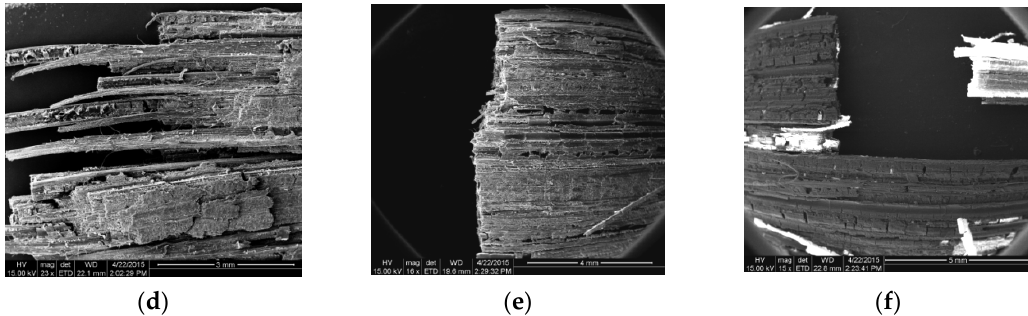
Figure 6. SEM images of typical tensile fracture surfaces of natural rattan bast strips evaluated in test 1: splintering tension ( a ), brash tension ( b ), and combined splintering and brash tension ( c ); natural rattan core strips: splintering tension ( d ), brash tension ( e ) and combined splintering and brash tension ( f ).